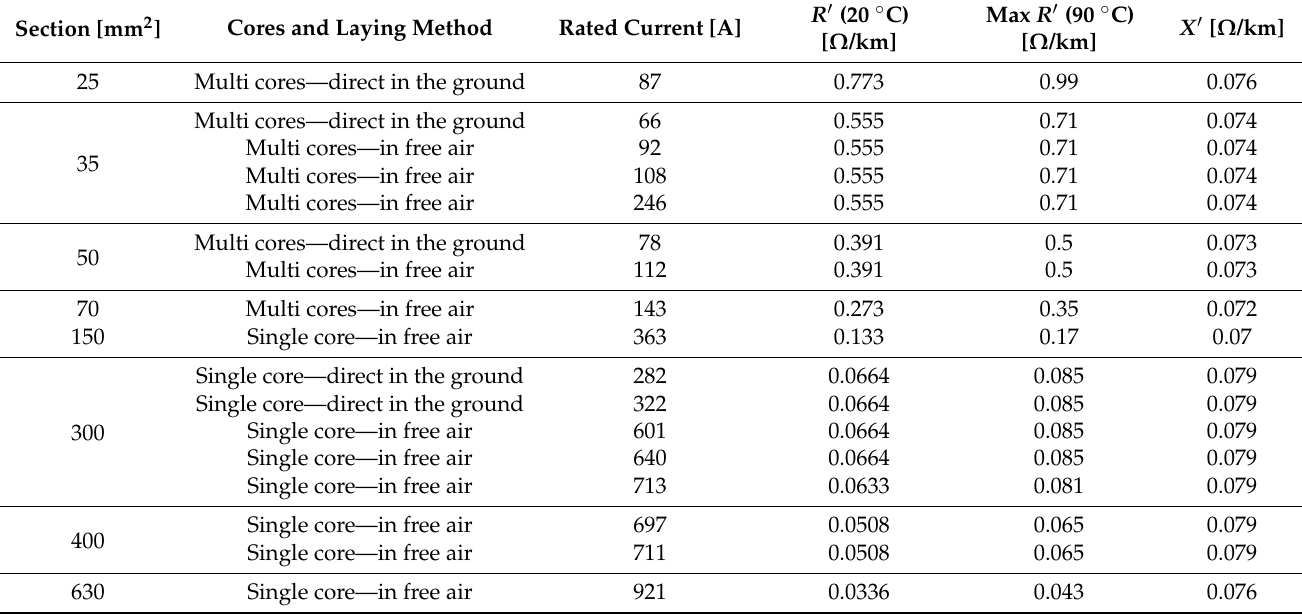
Table 12. Electrical data and technical characteristics assumed for 0.4 kV cables.